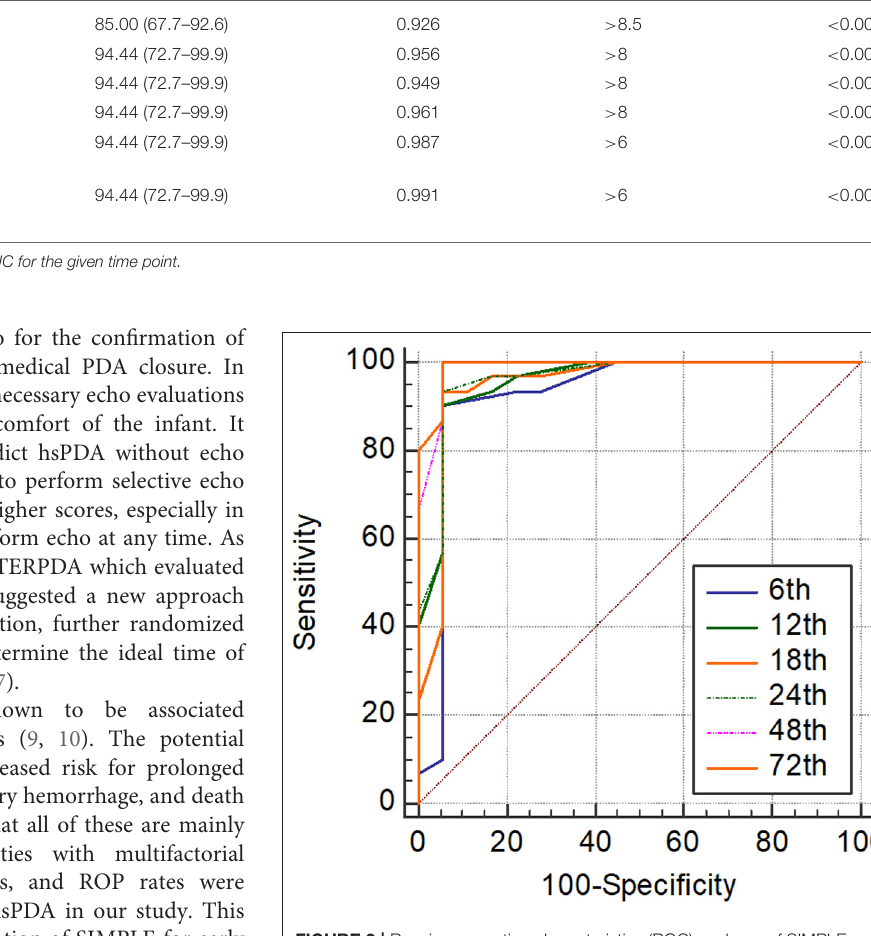
FIGURE 2 | Receiver operating characteristics (ROC) analyses of SIMPLE scoring system at each time